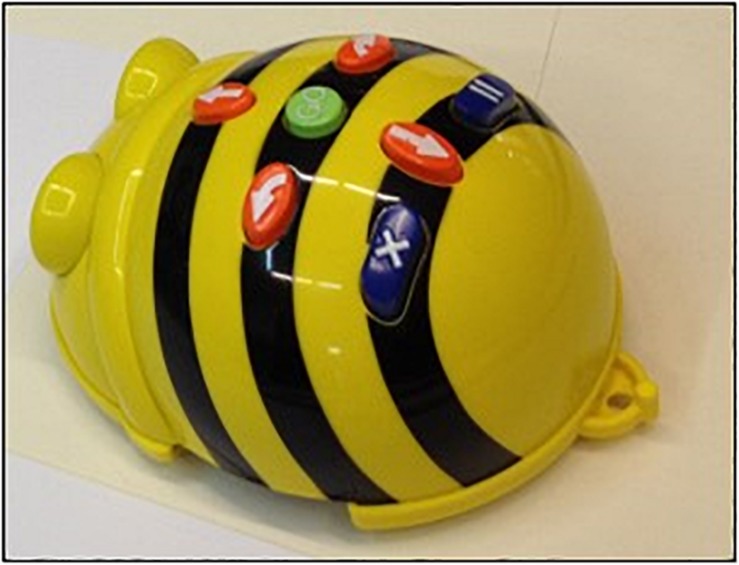
The Bee-bot robot.